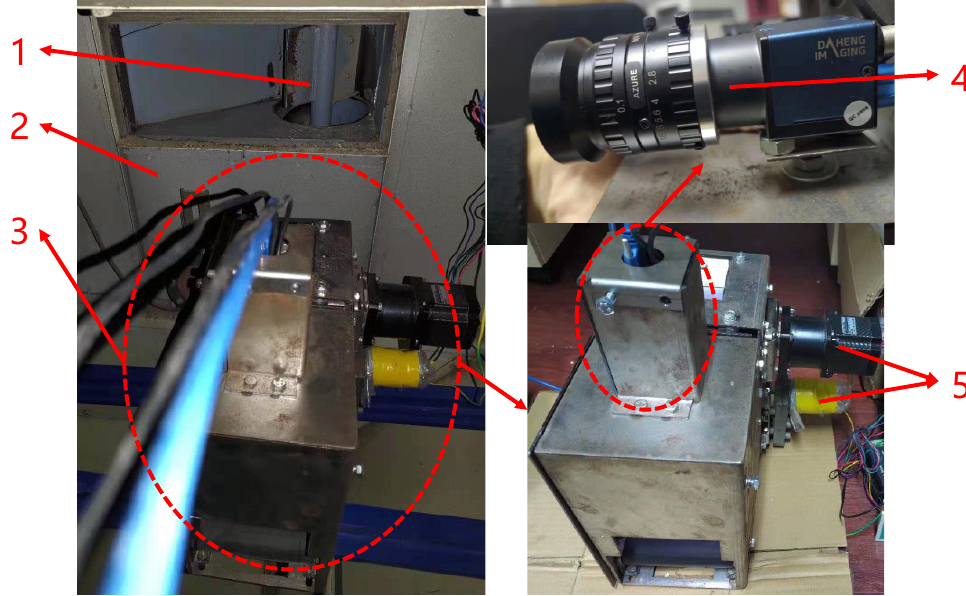
Figure 9. Image acquisition and recognition experiment of harvested corn grains. (1) Grain churn, (2) grain tank, (3) corn harvesting grain sampling monitoring device, (4) industrial camera, and (5) motor.